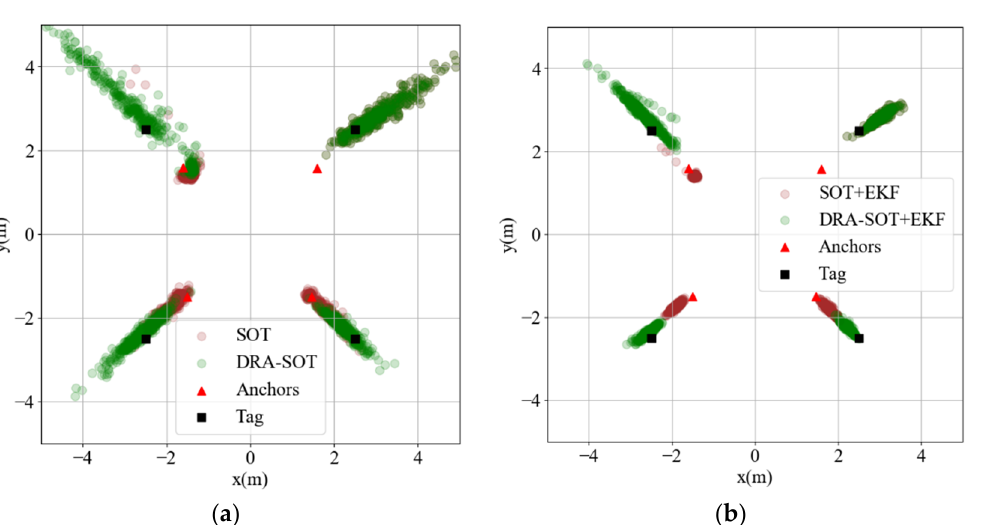
Figure 10. Experiment results ( a ) without extended Kalman filter (EKF), ( b ) with EKF.